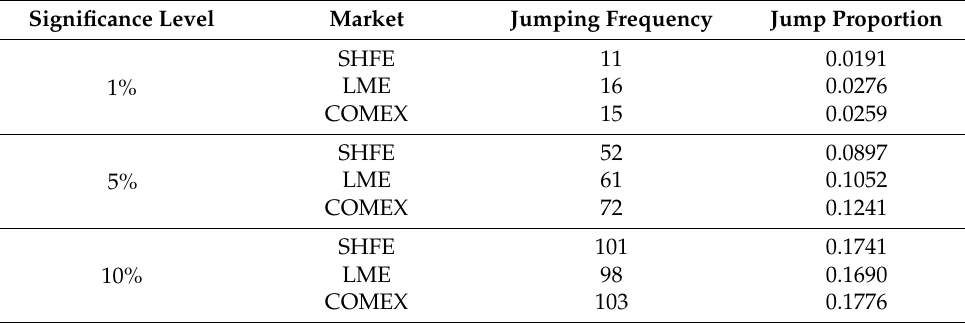
Table 15. Jump times for a single market.